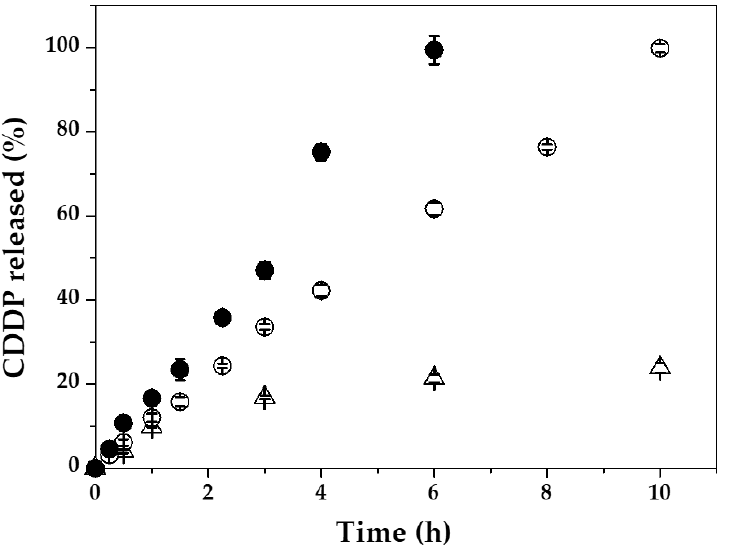
Figure 8. In-vitro release of CDDP (%) from the ( γ -Fe 2 O 3 /PLGA)/CS (core/shell)/shell NPs as a function of the incubation time (h) at pH 7.4 ± 0.1 and 37.0 ± 0.5 °C ( Δ ), pH 7.4 ± 0.1 and 45.0 ± 0.5 °C ( ○ ), and pH 5.0 ± 0.1 and 45.0 ± 0.5 °C ( ● ).